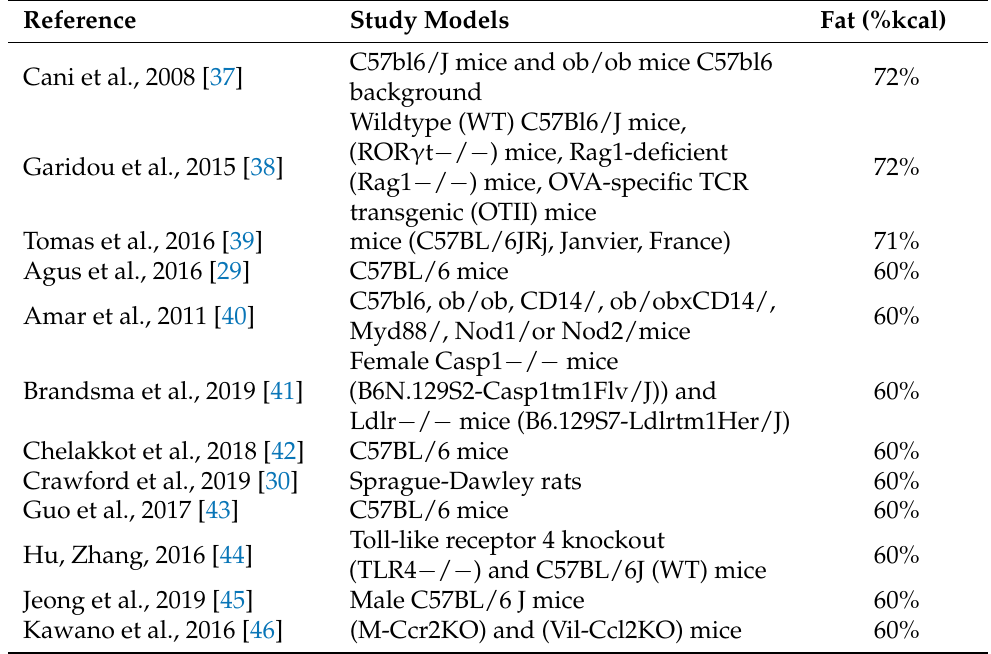
Table 1. High-fat